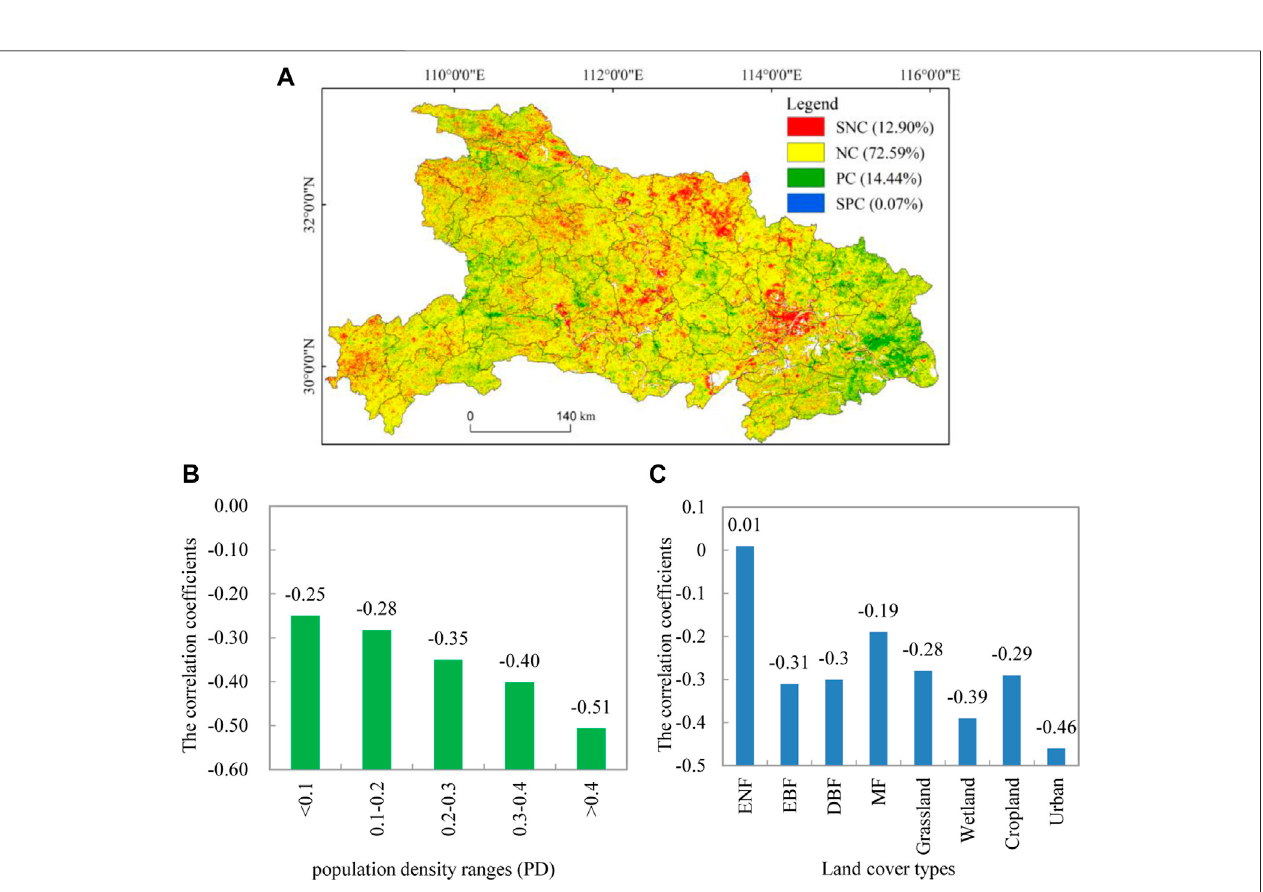
population densities of 12 years were quite different, the trends in NPP were the same. With an increase in population density, the average NPP value decreased. Figure 8B shows the annual